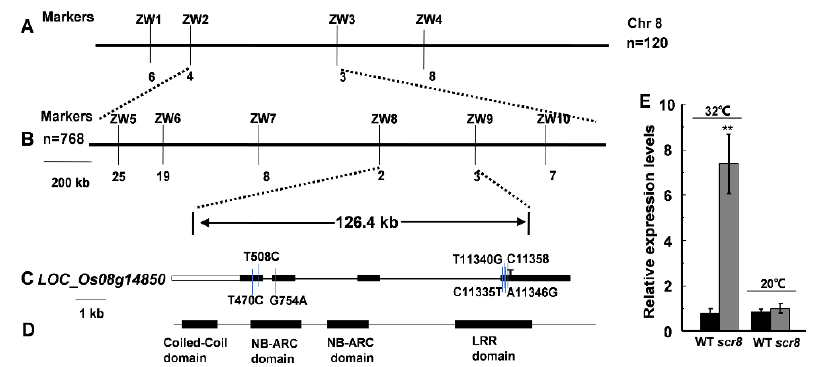
Figure 6. Fine mapping of the SCR8 gene. ( A , B ) Fine mapping of the SCR8 gene. ( C , D ) Structure analysis of SCR8. ( E ) Relative expression level of LOC_Os08g14850 grown at 32 °C and 20 °C. Error bars represent SD. ** Significant difference at p < 0.01 compared with the WT by Student’s t -test.